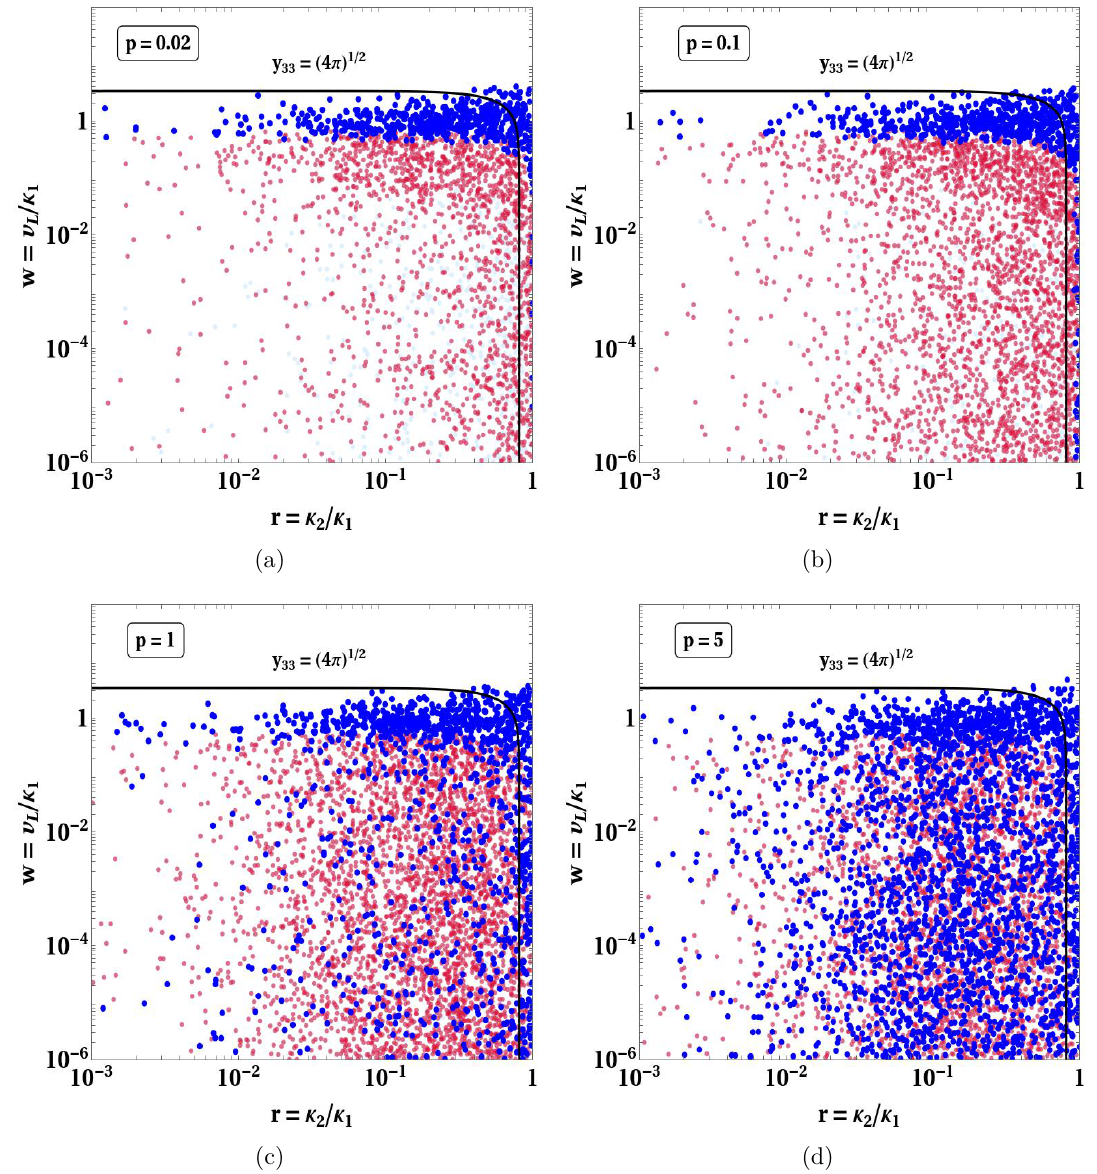
Figure 4. Allowed points on the r - w plane with random values of α 1 , 2 , 4 ∈ [10 − 3 , 4 π ] , λ 2 , 3 , 4 ∈ [10 − 3 , 4 π ] , ρ [0 . 1 , 8 π/ 3] , q = 1 , while (a) p = 0 . 02 , (b) p = 0 . 1 , (c) p = 1 , and (d) p = 5 . The 1 ∈ colour coding is the same as figure